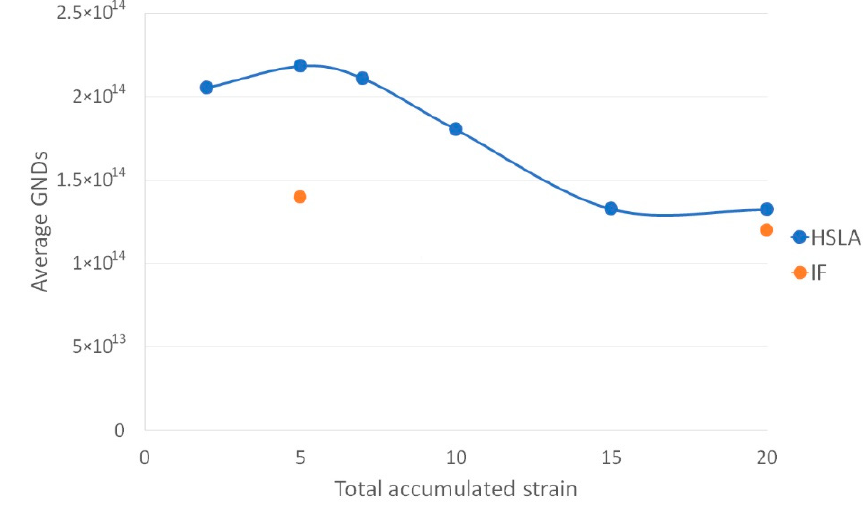
Figure 5. Average GNDs’ densities as a function of total accumulative strain.